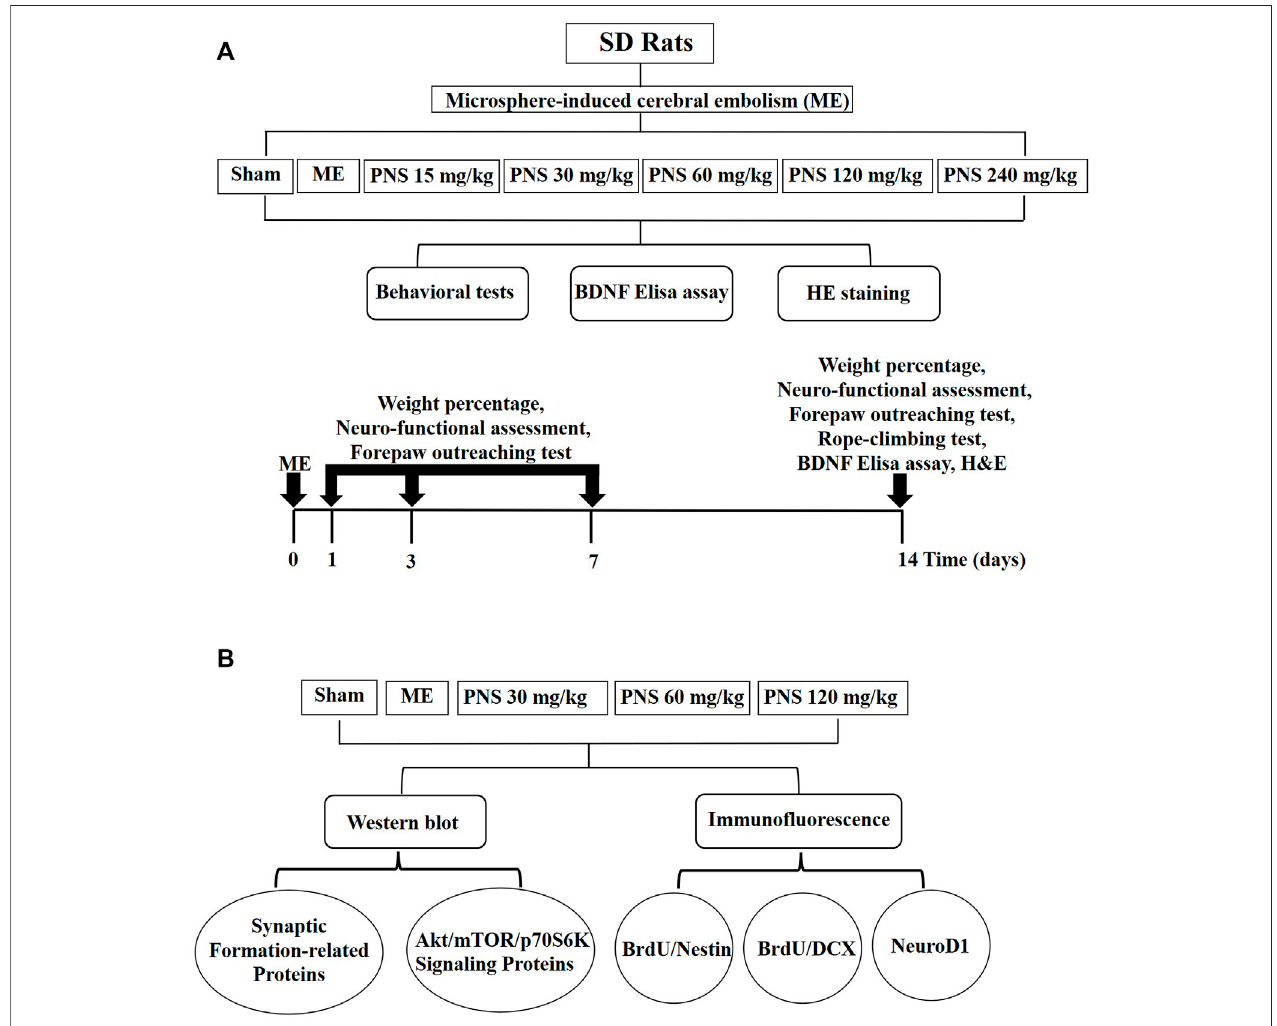
FIGURE1| Diagramofexperimentalprotocols. (A) ScreeningschemeoftheappropriatelyeffectivePNSdoes (B) MechanismofPNSpromotingneuralrepairafter cerebral ischemia.